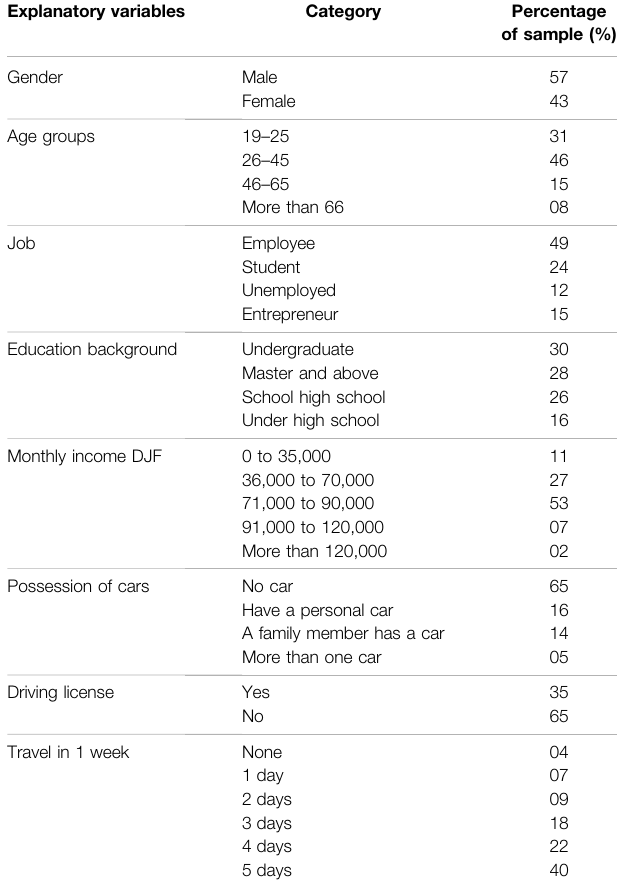
TABLE 2 | Socio-demographic characteristic of the sample.